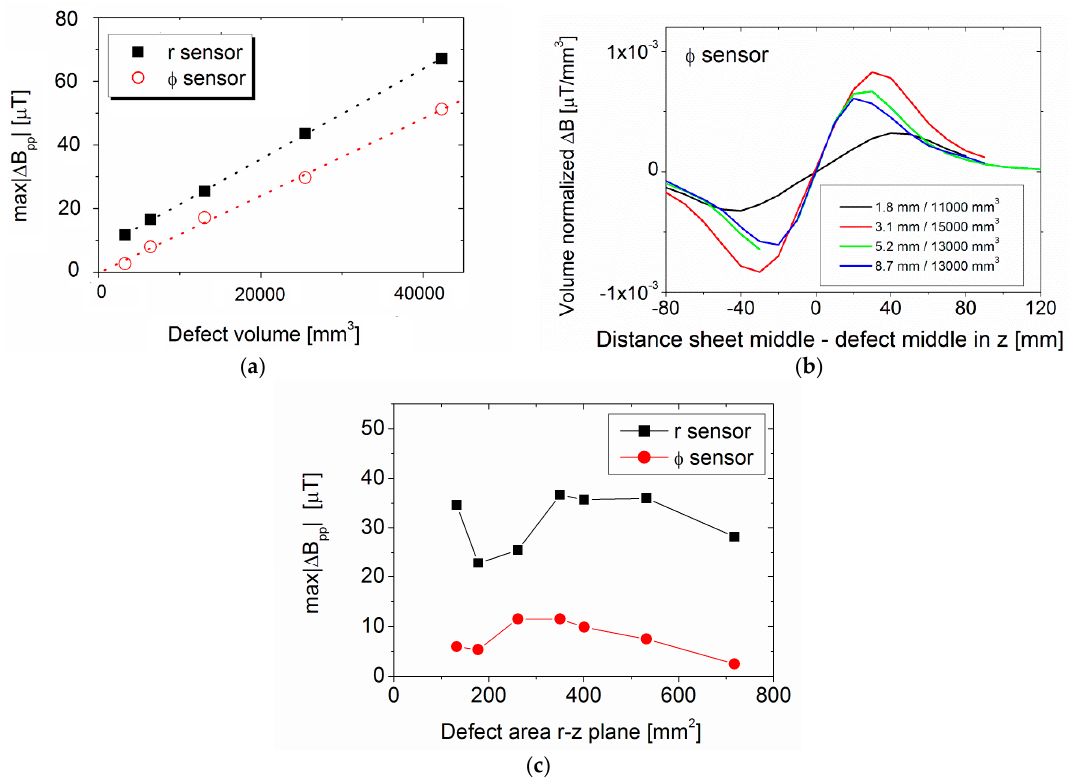
Figure 15. FEM simulations ( a ) maximum peak-to-peak change in magnetic field amplitude for defects with constant average depth but varying defect volume; ( b ) defect volume normalized change in magnetic field amplitude of Φ -sensor signal for defects with similar volume but different average defect depth; ( c ) maximum peak-to-peak change in magnetic field amplitude for defects with constant volume and constant average depth but changed cross-sectional area.